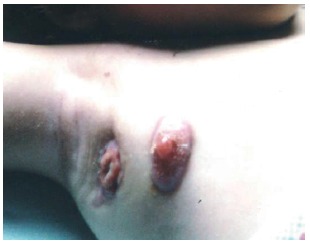
Lesão supurativa axilar e infra-axilar direita após a vacinação com
BCG.